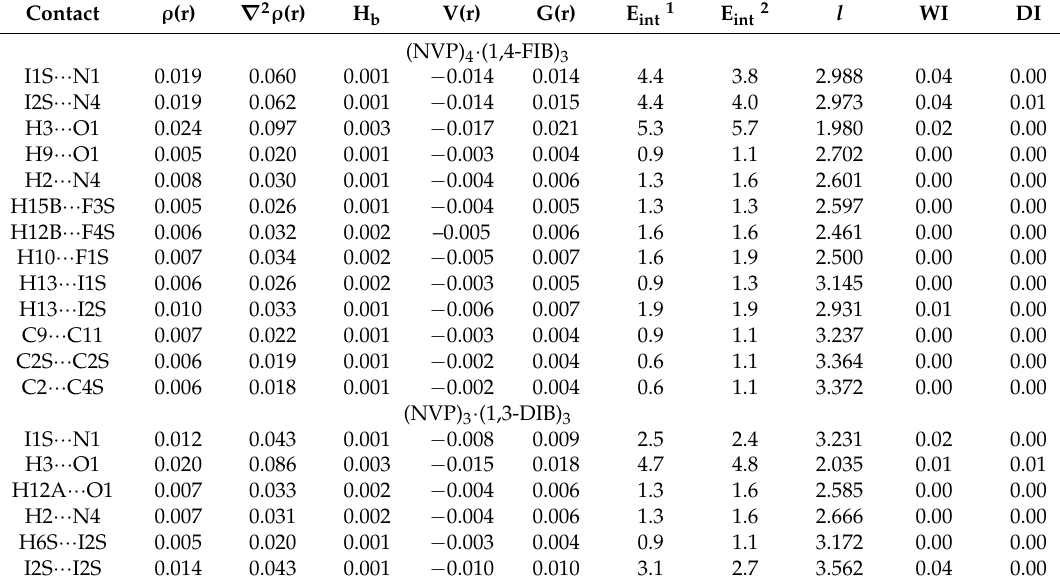
Table 2. Values of the density of all electrons— ρ ( r ), Laplacian of electron density— ∇ 2 ρ ( r ), energy density—H b , potential energy density—V( r ), Lagrangian kinetic energy—G( r ) (a.u.) at the bond critical points (3, − 1), corresponding to different noncovalent interactions in (NVP) 4 · (1,4-FIB) 3 and